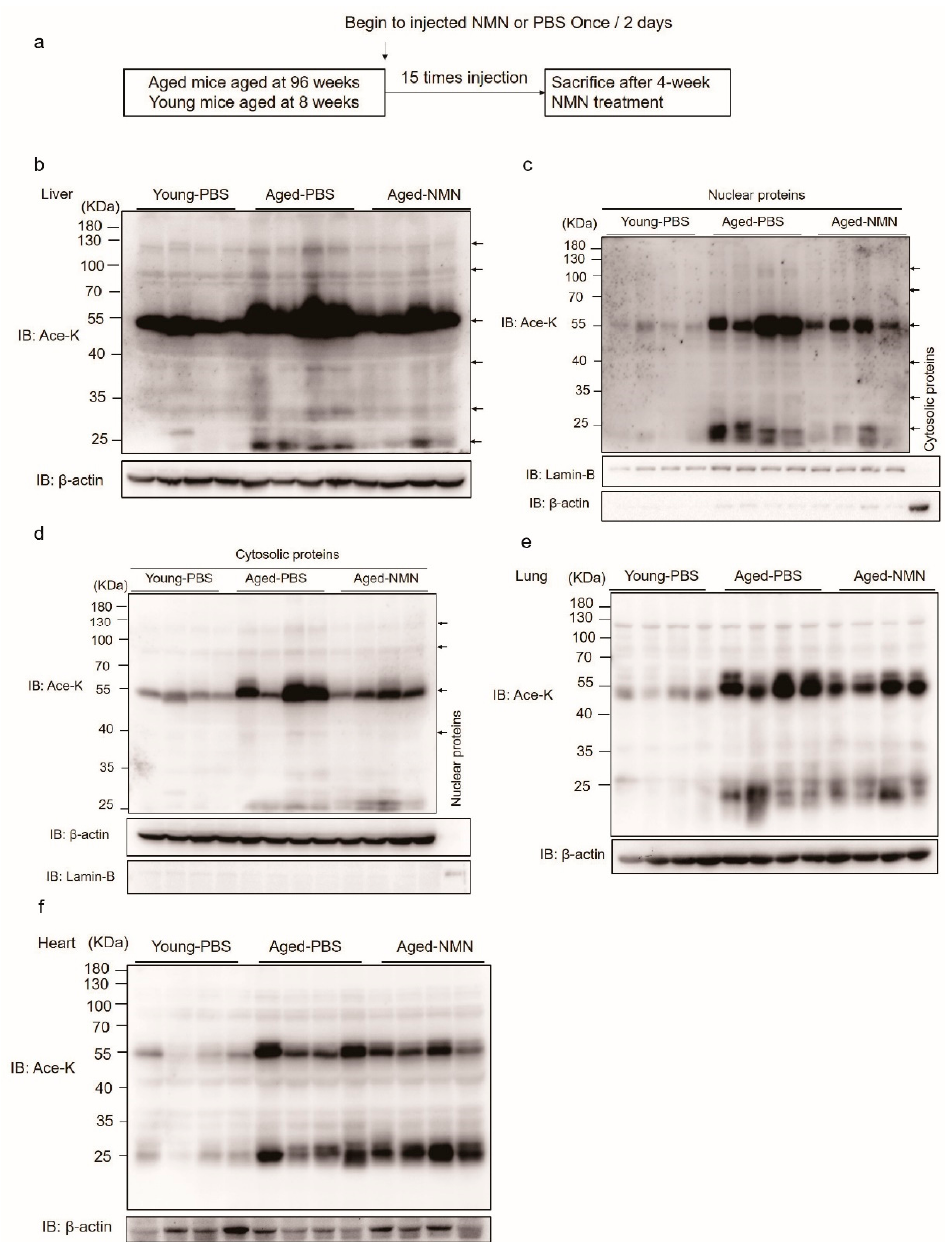
Figure 1. Protein acetylation in different organs and subcellular compartments in aged- and